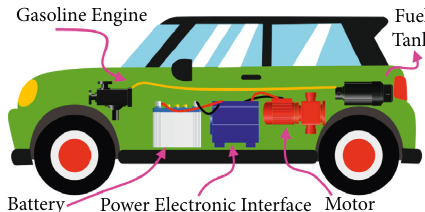
Figure 2: Battery electric